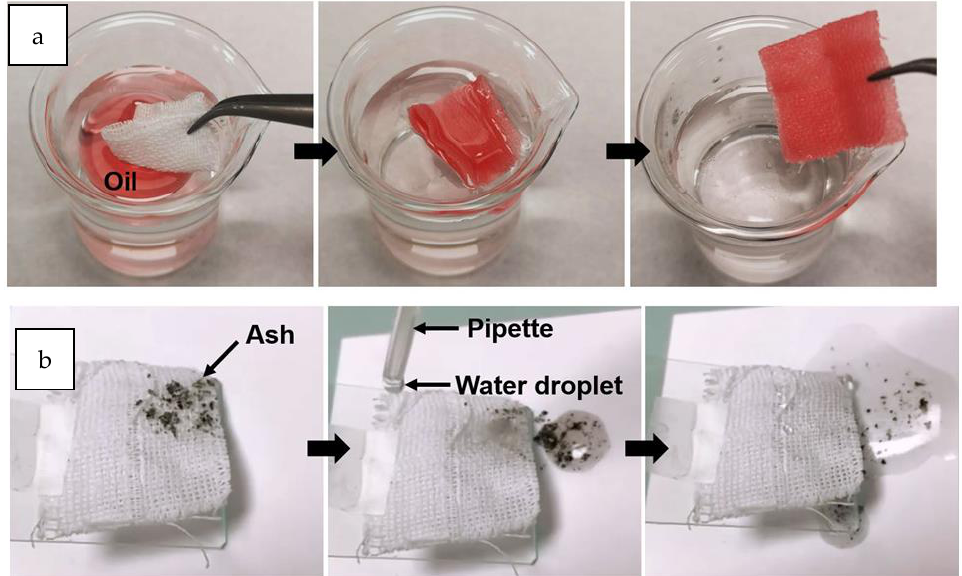
Figure 29 . ( a ): Oil absorption process by PS/SiO 2 -coated textile from the water surface, ( b ): Surface self-cleaning effect of PS/SiO 2 -coated textile. Reprinted with permission from ref. [72].